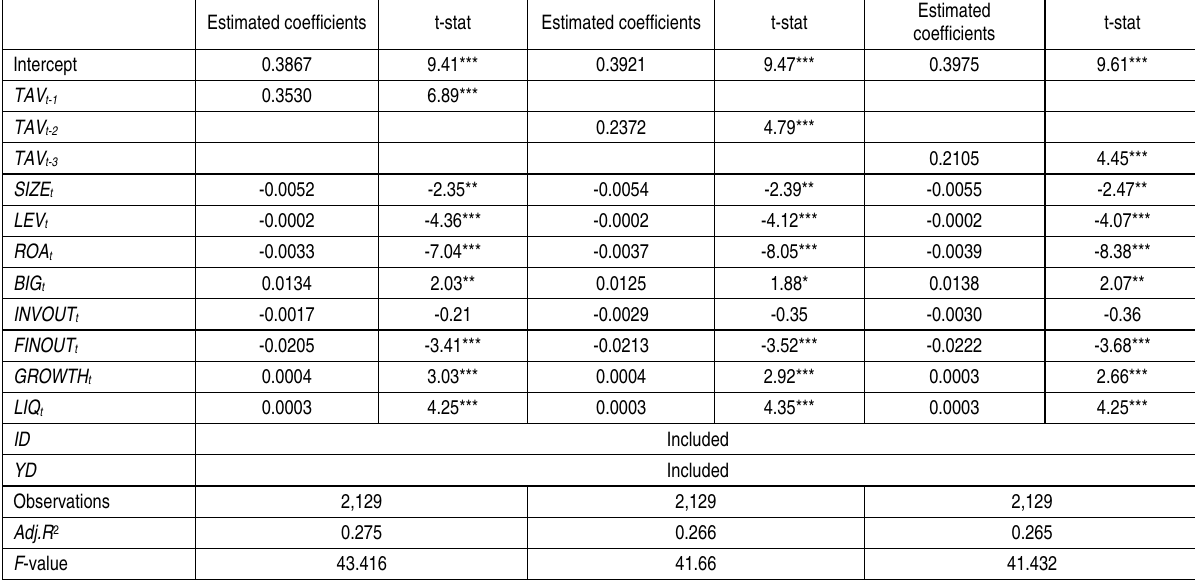
Table 3. Regression results on Hypothesis 1